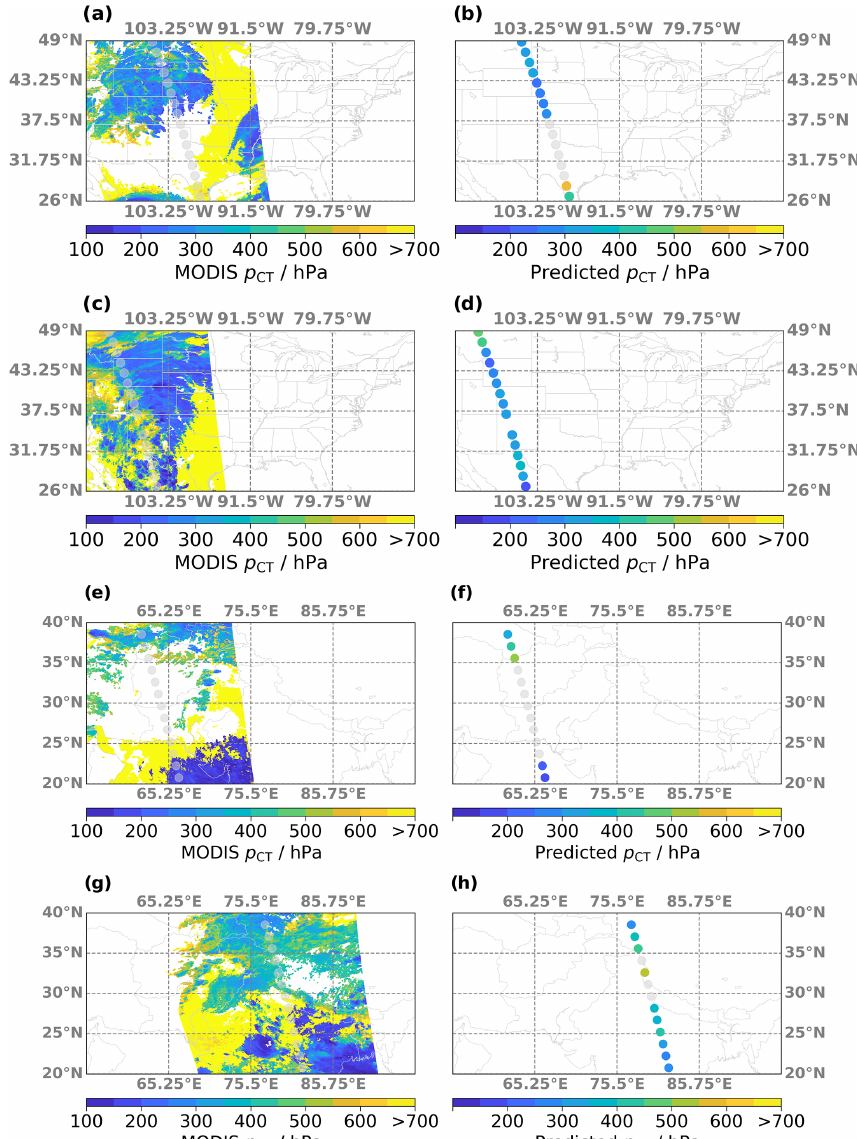
Figure 12. (a) Map of cloud top pressure ( p CT ) retrieved from MODIS observations on 31 August 2017 over North America. Transparent circles indicate the MLS orbit. (b) Same as (a) but for the predicted p CT based on the ANN algorithm. (c, d) Same as (a, b) but for MLS and MODIS observations on 5 July 2015. (e, f) Similar to (a, b) but for MLS and MODIS observations on 28 June 2019. (g, h) Same as (a, b) but for MLS and MODIS observations on 5 July